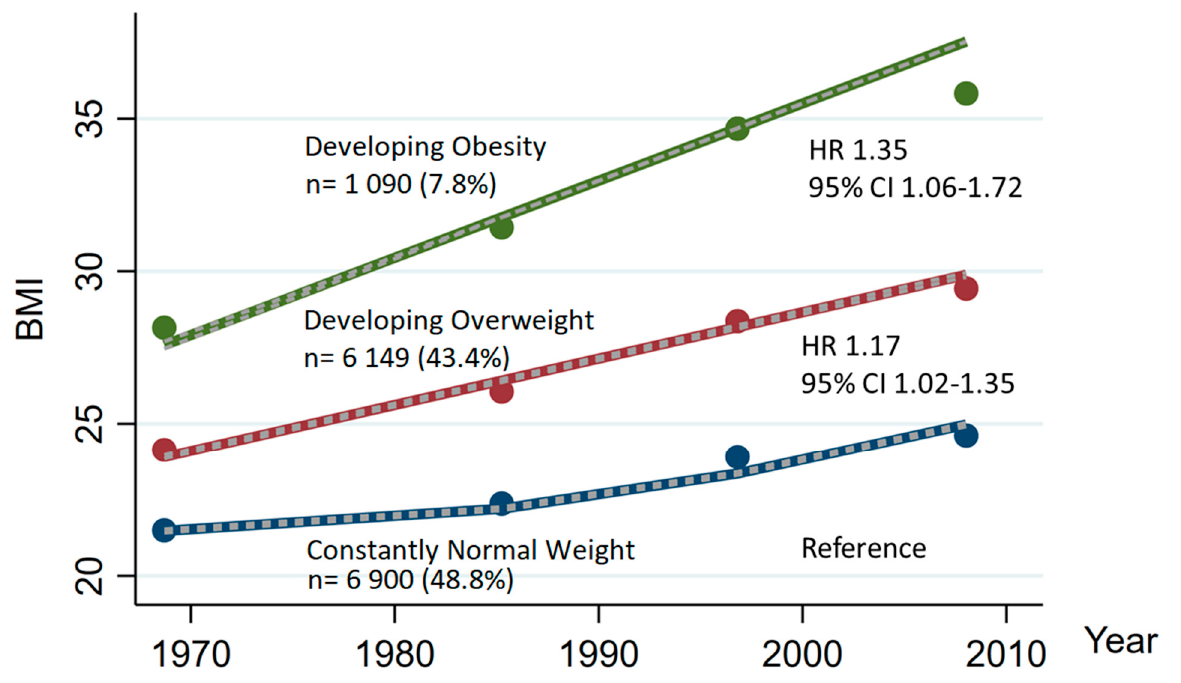
Figure 3. Group Based Trajectories of BMI over 42 years and Risk for Ischemic Stroke. HR Adjusted for Covariates of Model 2.